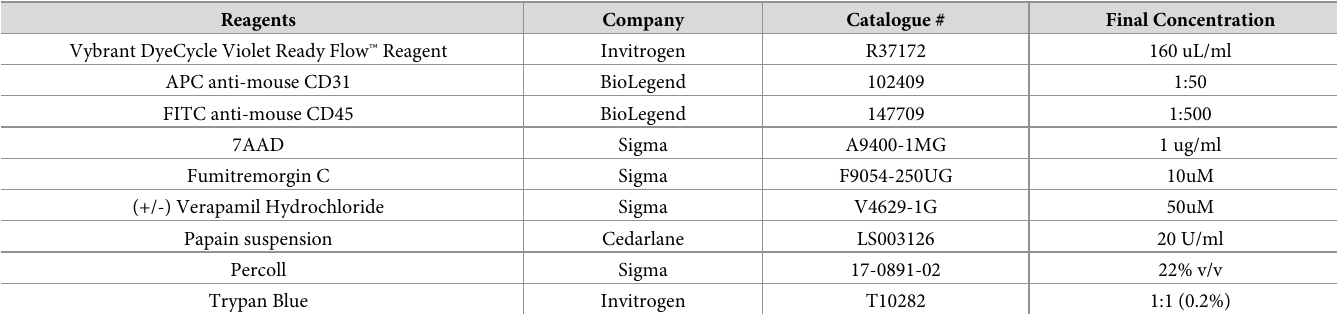
Table 1. Reagents used for tissue processing and DCV